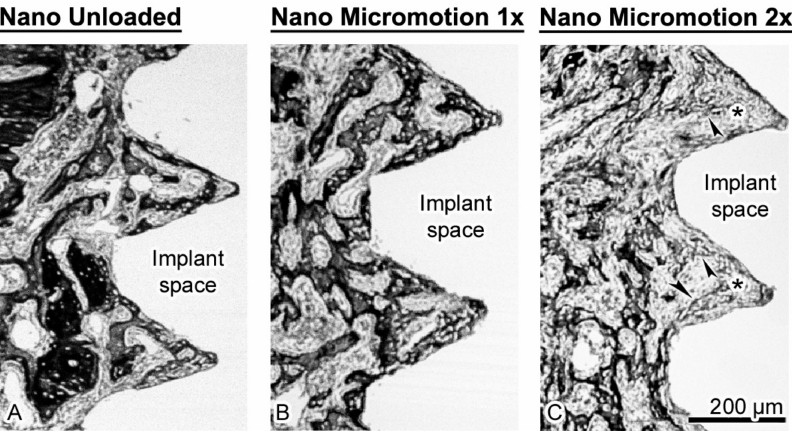
Figure 5. Scanning electron images taken using the backscatter mode showing the ( A ) Nano Unloaded; ( B ) Nano Micromotion 1x and ( C ) Nano Micromotion 2x groups at 7 days post-surgery. In the Nano Unloaded and Nano Micromotion 1x groups, trabecular bone (black) was found all around the implant, including between the threads ( A , B ). However, in the Nano Micromotion 2x group the region close to the implants exhibited only sporadic and thinner bone trabeculae (arrowheads) and was mainly occupied by fibrous tissue (asterisks) ( C